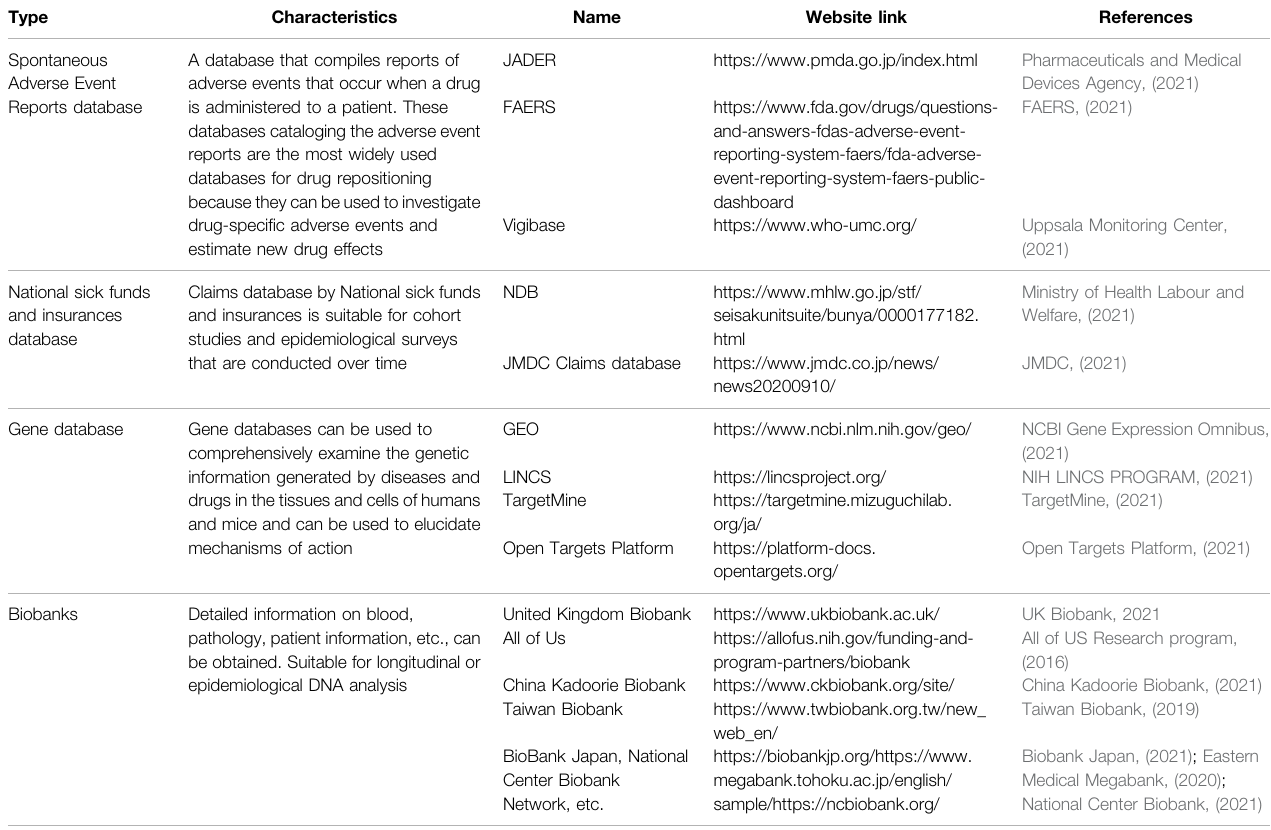
TABLE 1 | Examples of medical information databases and life science